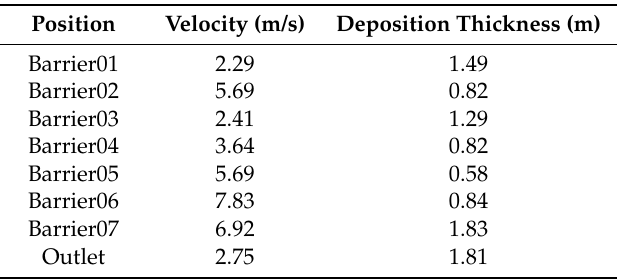
Table 1. Debris flow field data at the main gully in